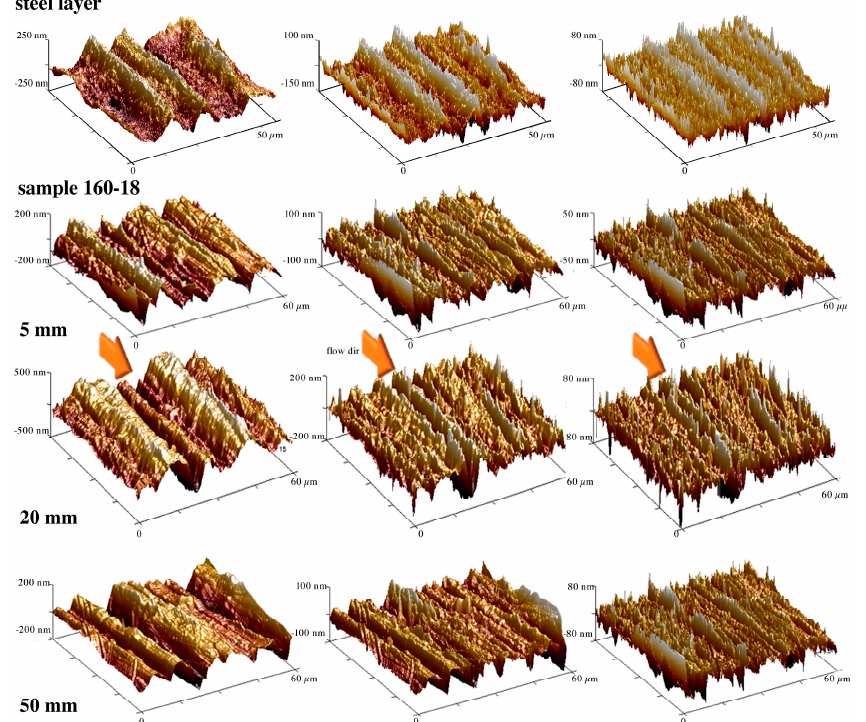
Figure 5. Topographies of the steel layer and of the sample 160-18 at different distances from the gate. From left to right are reported the atomic force microscopy (AFM) maps processed by applying a flatten procedure and two high pass horizontal filters, 0.1 and 0.2 µ m − 1 cut off frequency.